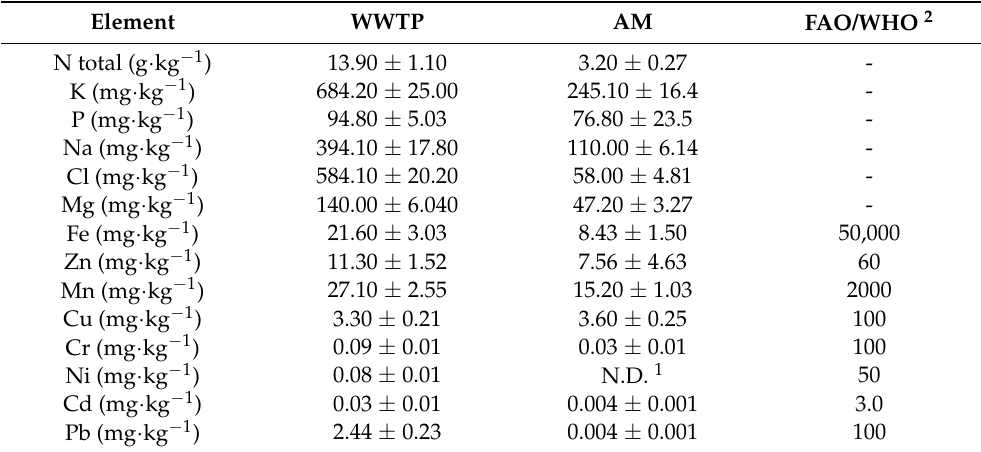
Table 4. Soil chemical analysis of various ions at both Wadi-Musa Wastewater Treatment Plant (WMTP) and Ain Mousa (AM) experimental sites. The data are averages ± SD ( n = 4). Element